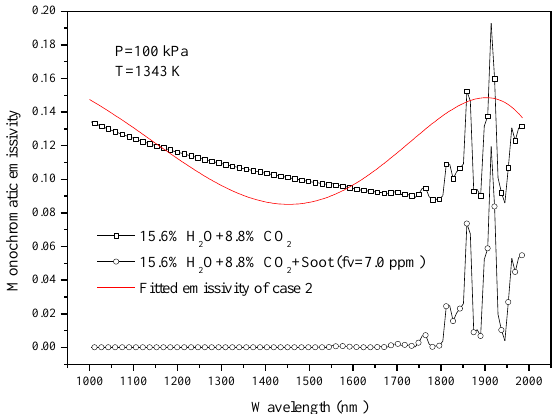
Figure 11. The monochromatic emissivity of the mixtures of CO 2 , H 2 O, and soot.